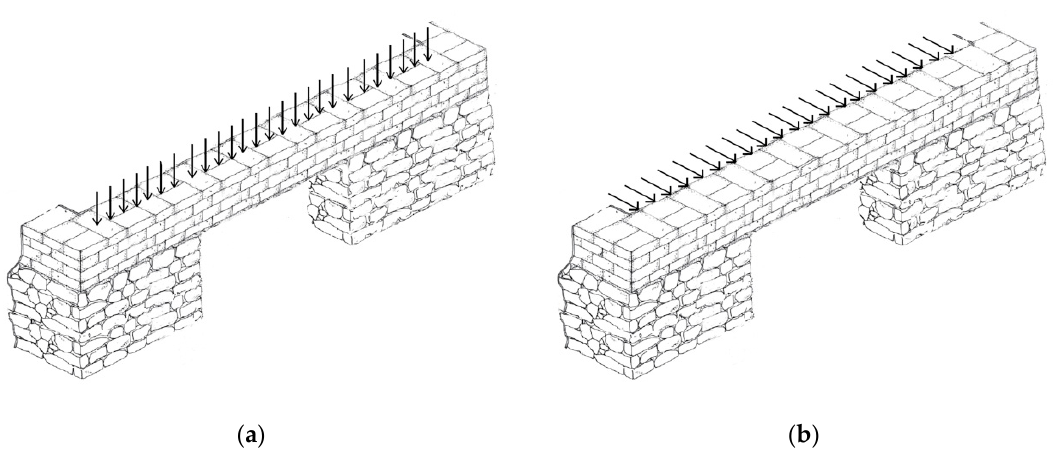
Figure 1. Reinforced masonry beams differently loaded with respect to the bed joints: ( a ) Loads orthogonal to the mortar layers; ( b ) Loads parallel to the mortar layers.